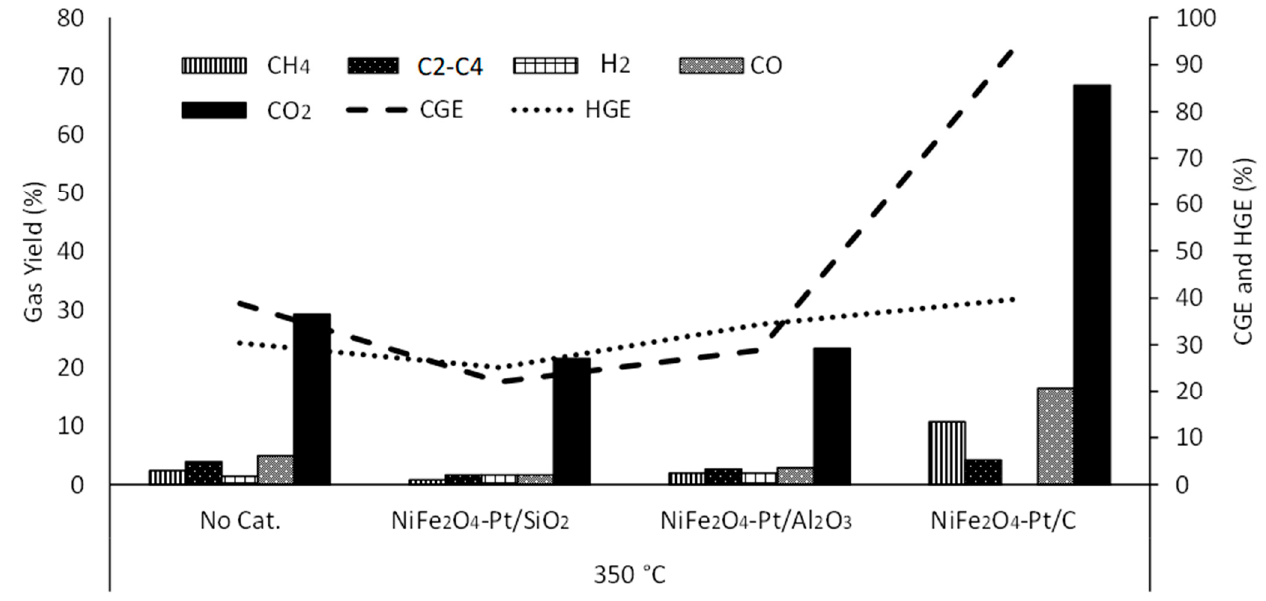
Figure 7. Effect of using 50/50 wt% combination of NiFe 2 O 4 and the Pt-based catalysts for catalytic reforming of glycerol at 350 °C.